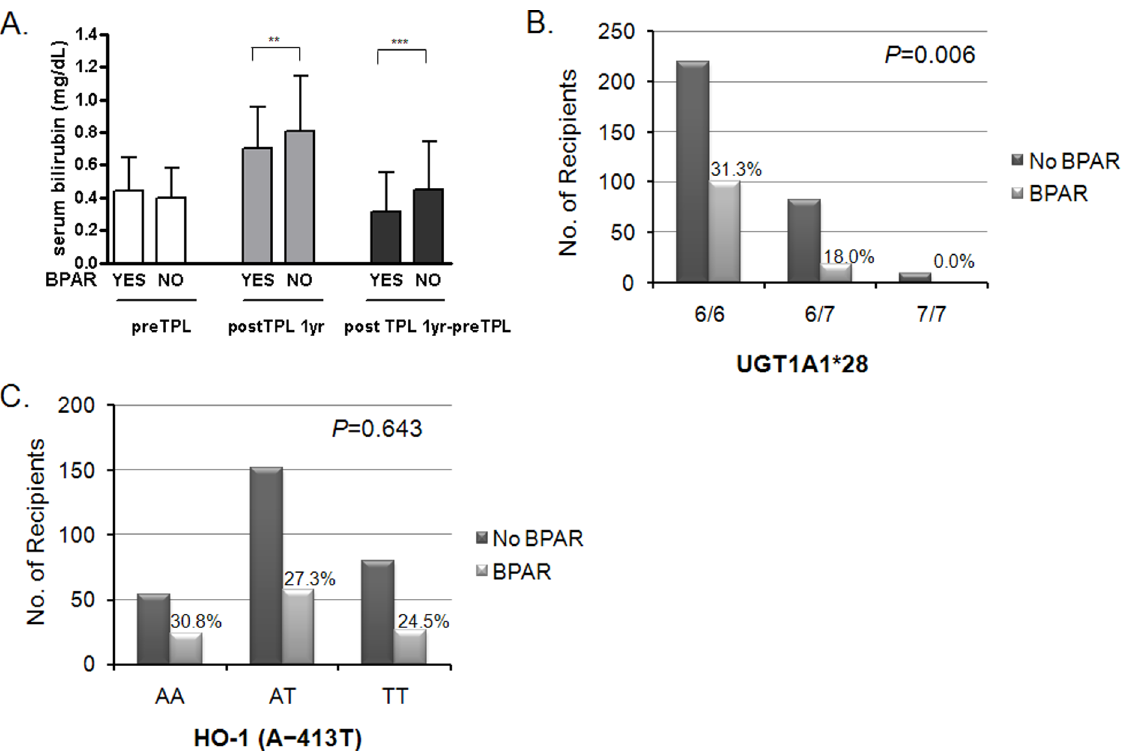
Figure 2. Associations between HO-1 and UGT1A1*28 sequence variations and the development of acute rejection. (A) Pre- and post- transplant serum bilirubin levels according to BPAR. (B) Incidence of BPAR according to UGT1A1*28 polymorphism. (C) Incidence of BPAR according to HO-1 (A-413T) polymorphism. Mean 6 SD. TPL, transplantation; postTPL 1yr-preTPL, difference in total bilirubin values between pre-transplant and 1 year post-transplant; BPAR, biopsy-proven acute rejection. ** P , 0.01; *** P , 0.001.